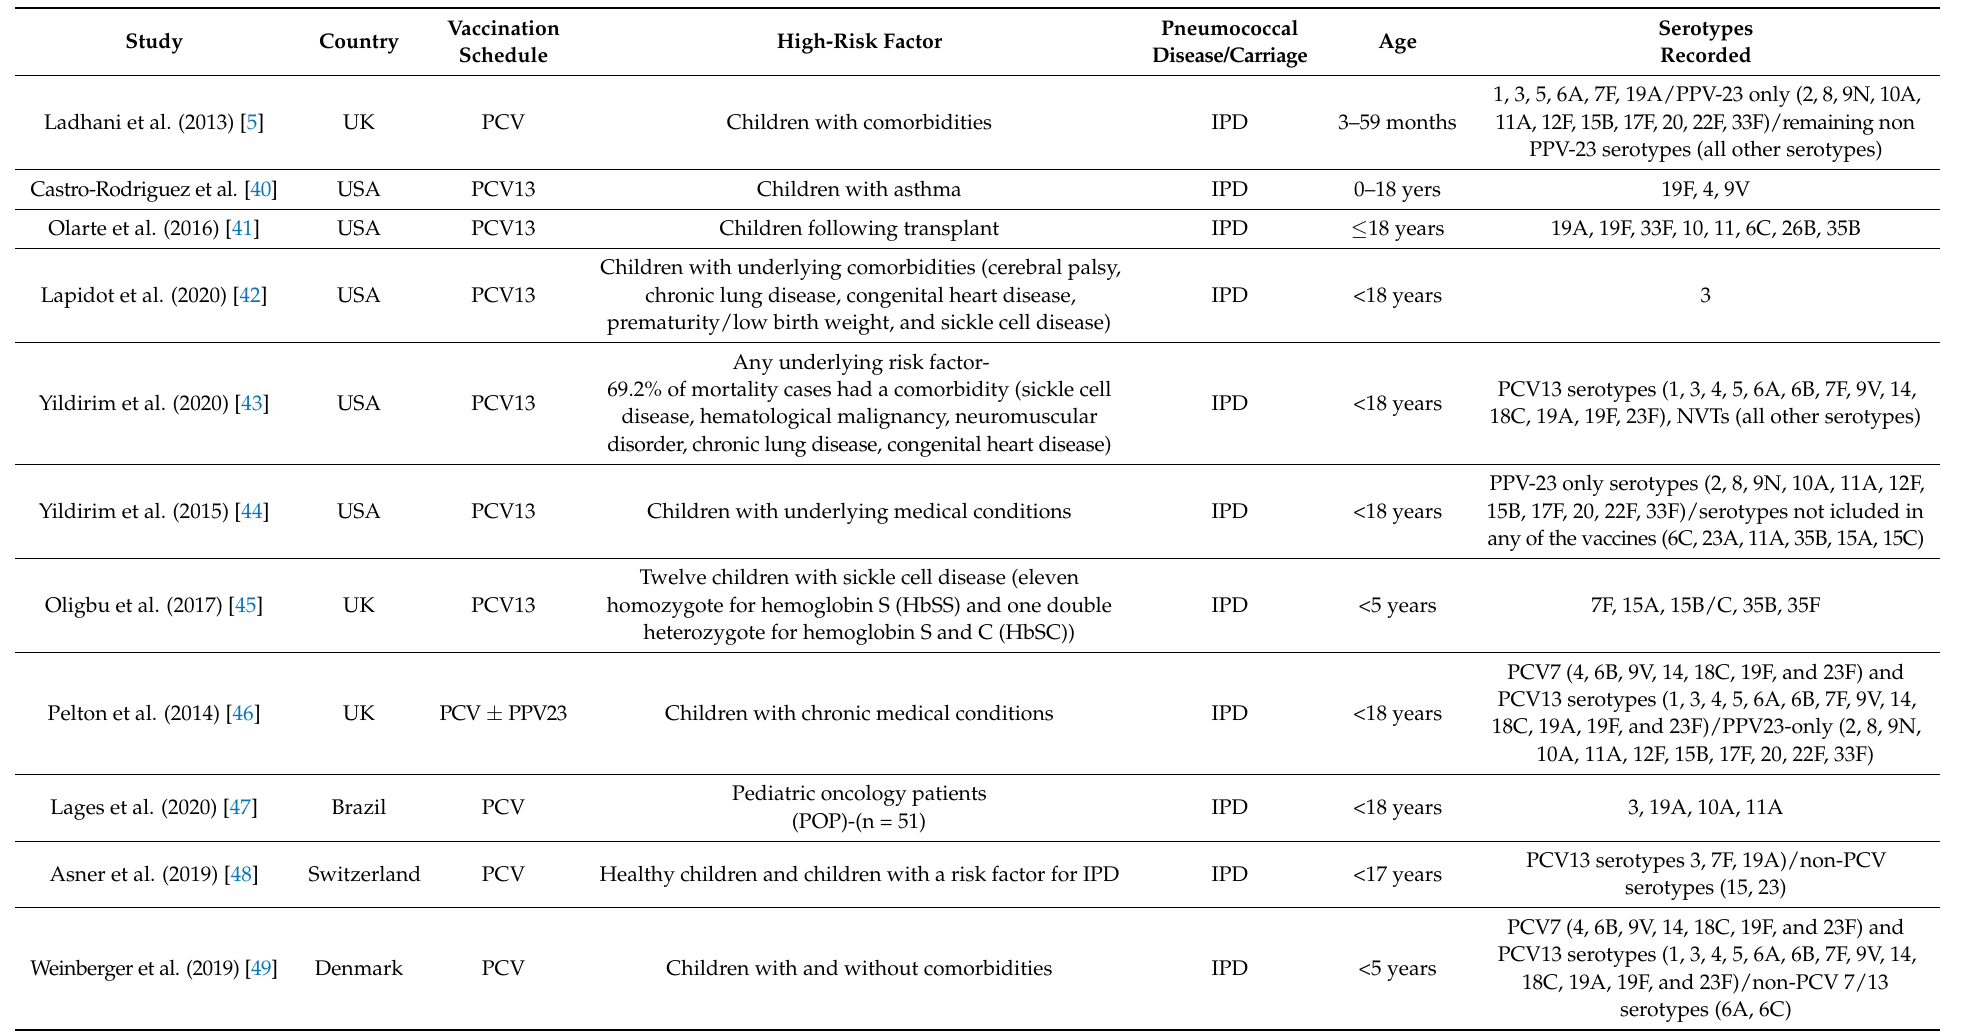
Table 2. Summary of studies showing the pneumococcal disease serotype epidemiology among pediatric populations at risk in the developed